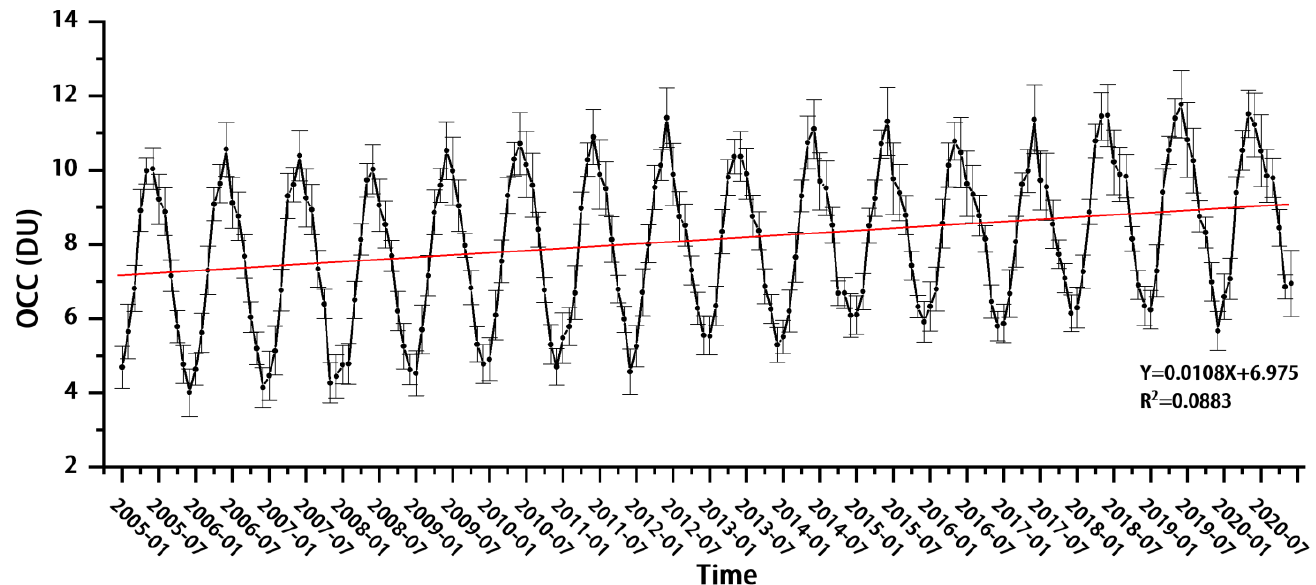
Figure 8. Variation trend of the annual mean value of the OCC LT over the entire Chinese land area from 2005 to 2020.